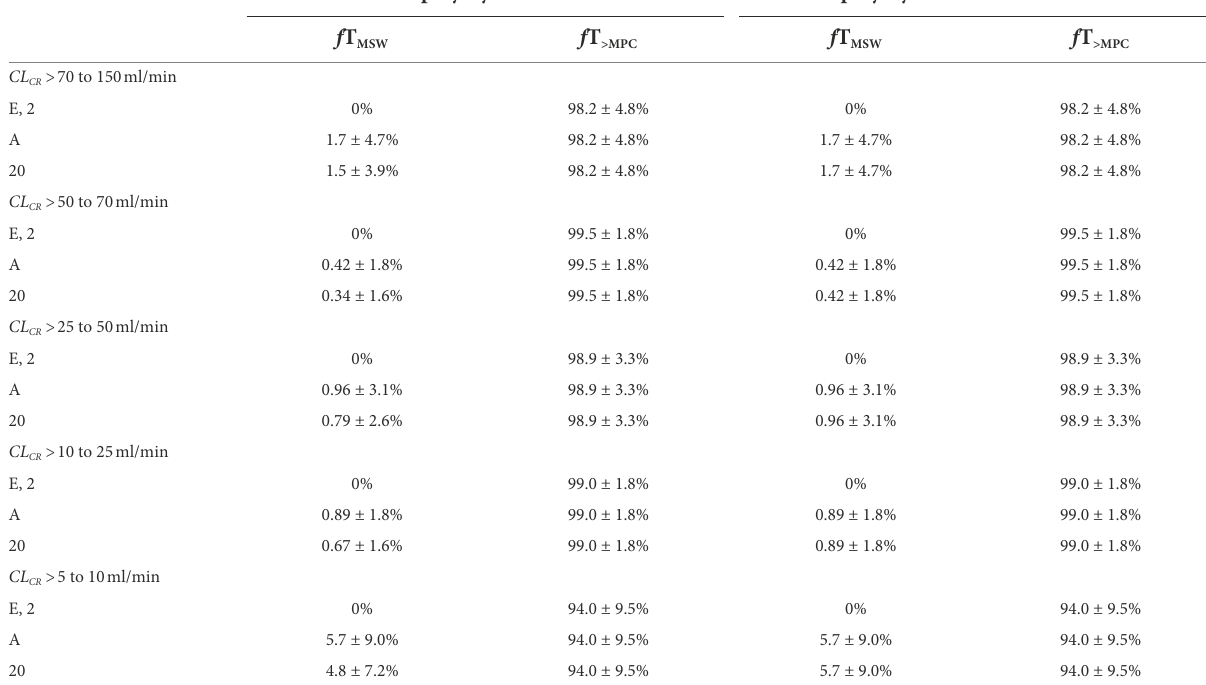
TABLE 5 Pharmacodynamic parameters f T MSW and f T >MPC based on MIC and MPC of meropenem in plasma against four A. baumannii isolates harboring OXA-23 and other serine- β -lactamases. Bacteria isolates